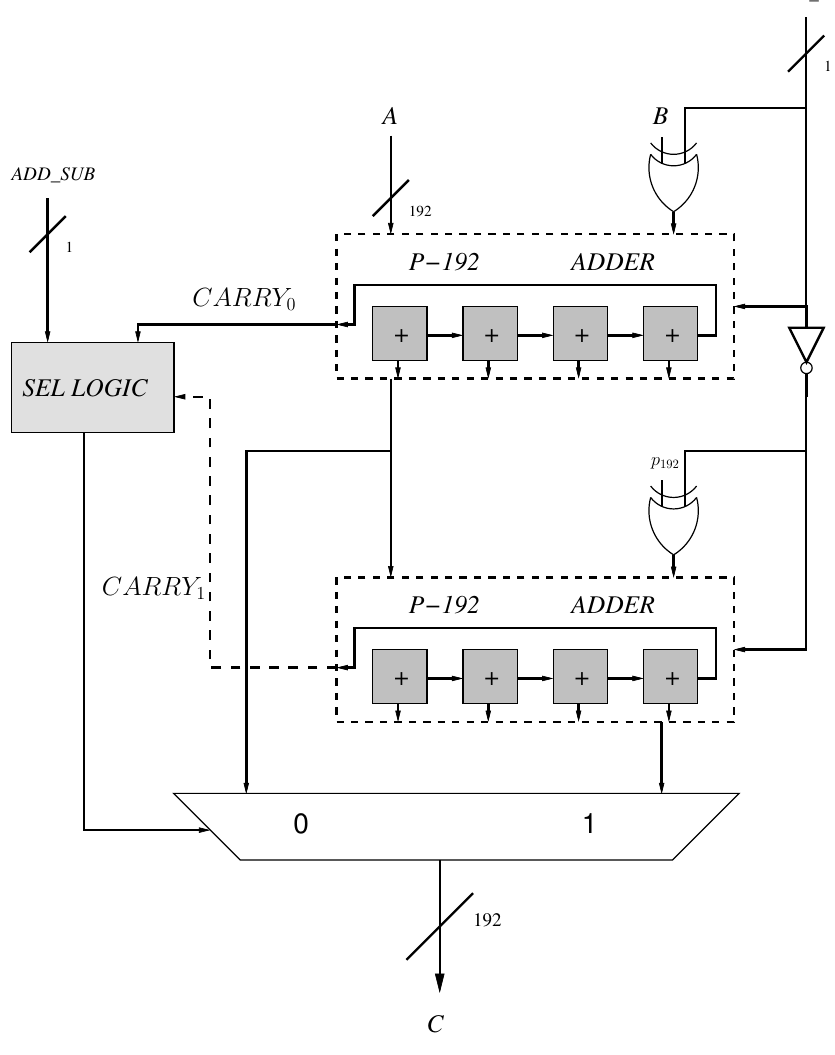
Figure 3. p modular adder and subtractor 192